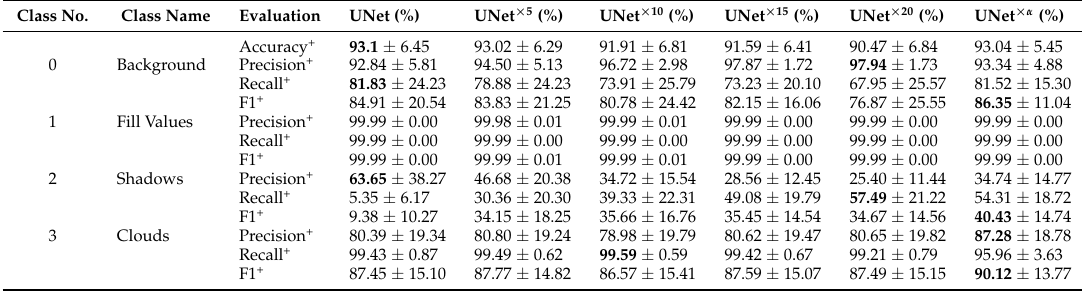
Table 3. Average scores of accuracy, precision, recall, and F1 for multiple UNet models without Dense CRF refinement. The top results are highlighted in bold.